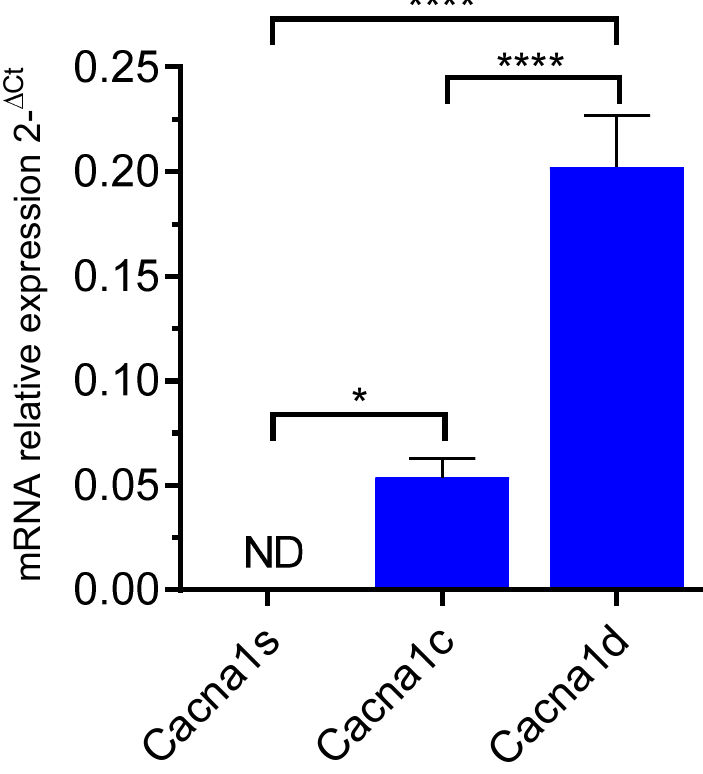
Figure 1. RT-qPCR amplification of LTCC genes in GH3b6 cells. The histogram illustrates the expression level of cacna1s , cacna1c, and cacna1d encoding Ca The data are mean of mRNA relative expression ±SEM. ND: Not Detected. One-way ANOVA ( p < 0.0001) followed by Tukey’s post hoc multiple comparison test was performed. * p < 0.05, **** p < 0.0001.